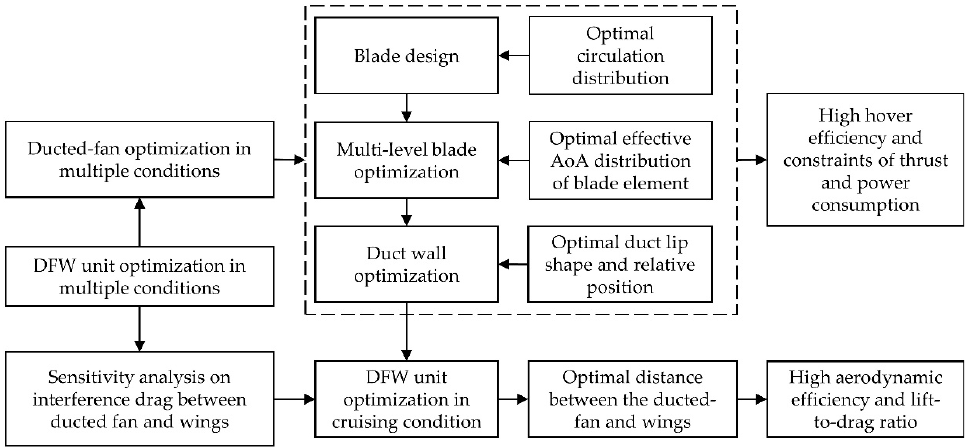
Figure 2. Flow chart of DFW unit optimization in multiple conditions.